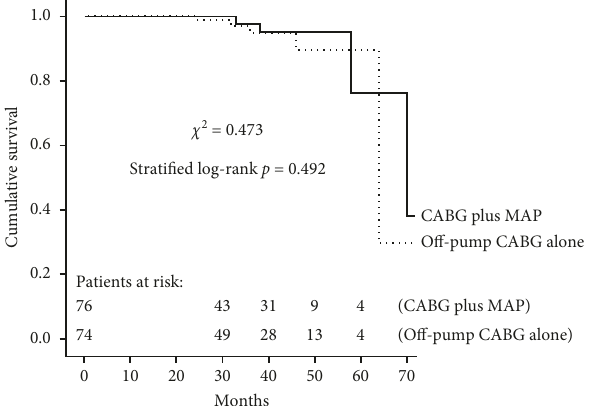
Figure 3: Kaplan–Meier analysis for overall survival in the matched population. CABG, coronary artery bypass grafting; MAP, mitral annuloplasty.